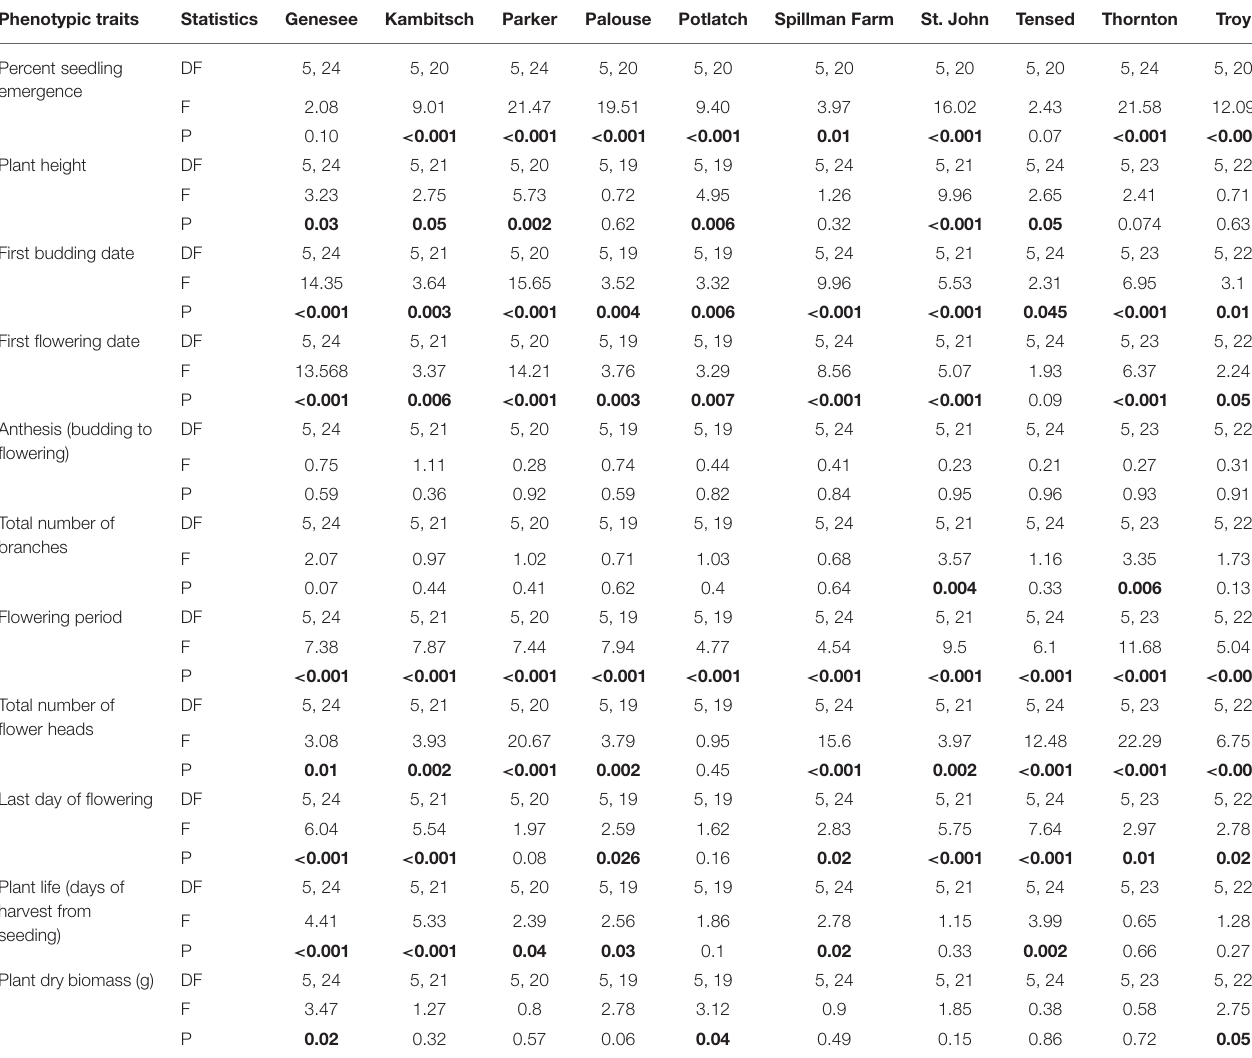
TABLE 1 | Mixed effect model results for 11 phenotypic traits comparing among half-sib families across 10 Anthemis cotula populations a . Phenotypic traits Statistics Genesee Kambitsch Parker Palouse